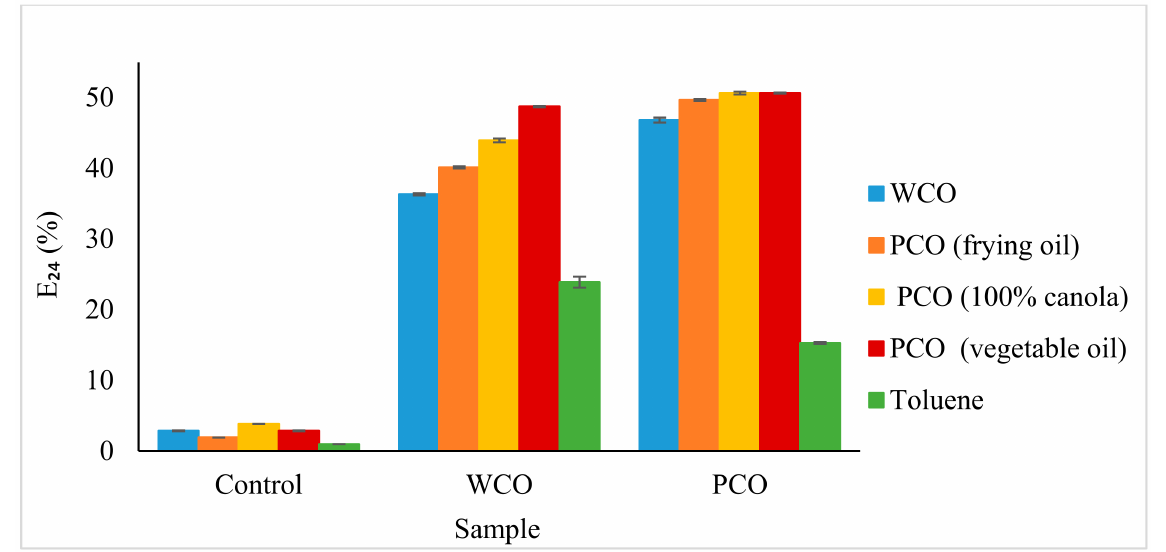
Figure 6. Emulsification index after a 24 h incubation (E 24 ) for both cell-free WCO and PCO MSM culture supernatants. Error bars represent mean ± standard error (SEM).